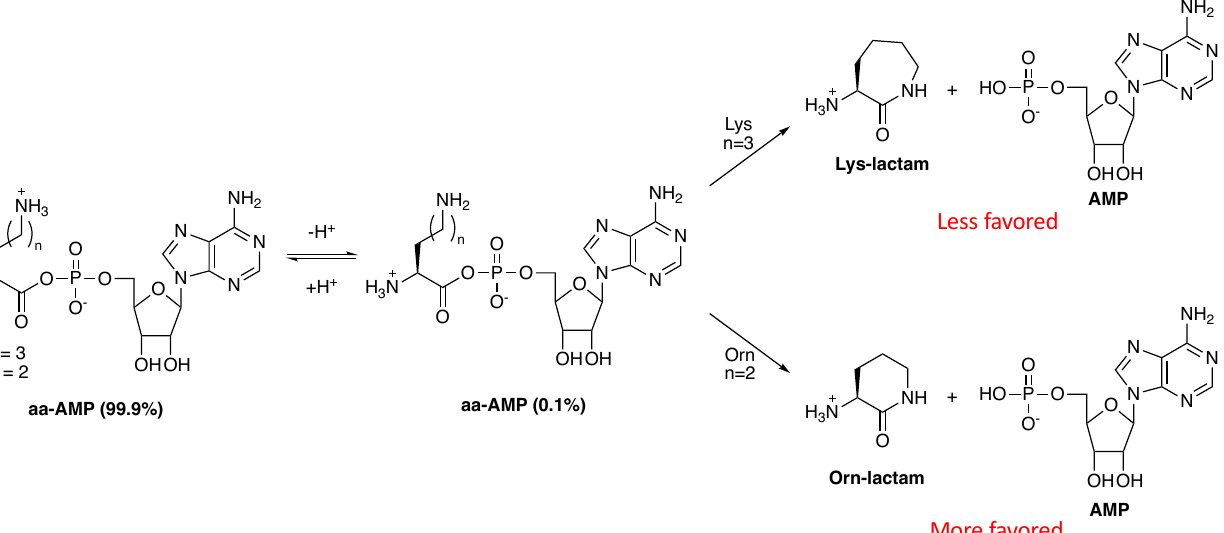
Figure 4. Cyclization reactions of Lys-AMP and Orn-AMP to the corresponding lactams. These intramolecular cyclization reactions would occur only when the ornithine and lysine side chains are deprotonated. Ring formation would further drive deprotonation. Formation of the six-membered ring Orn-lactam is favored ~500:1 over that of the seven-membered ring in the Lys-lactam